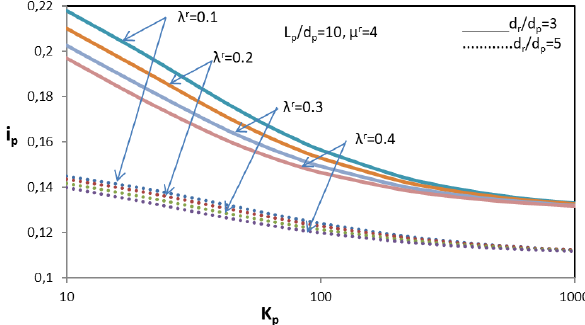
, considering radial displacement with p , of GP– effect of comparative length, p